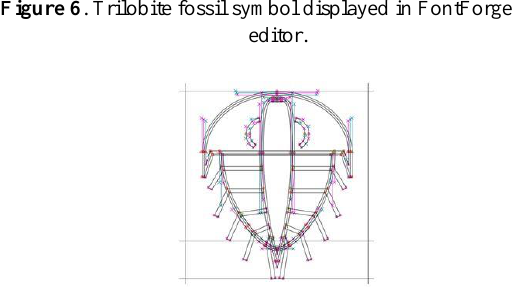
Figure 7 . Trilobite fossil symbol in FontForge construction viewer.